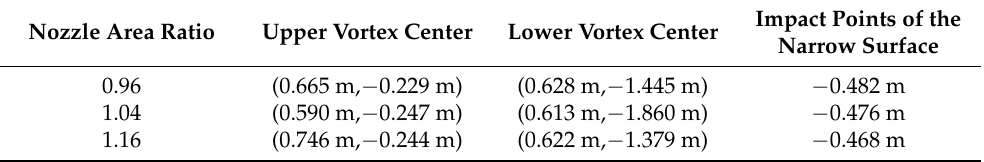
Table 4. Upper and lower flow vortex core position and narrow surface impact position.